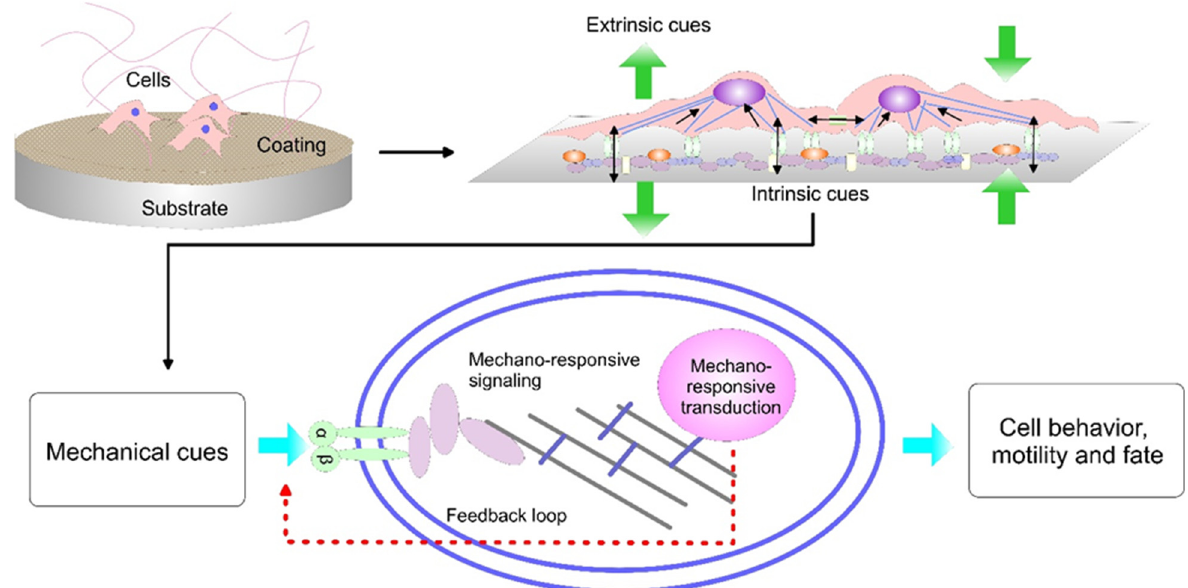
Figure 1. A schematic view of the influence of external mechanical forces and local (intrinsic) mechanical cues of the surrounding extracellular matrix on cell behavior of osteoblasts cultured on coated implants. The mechanical cues are transferred from the cell surface to the nucleus by the mechanisms of mechano-responsive signaling including the cytoskeleton. The mechano-responsive transduction activates downstream cell signaling cascades that determine the cell behavior, motility and fate. By a transcriptional feedback loop, the cells can change their mechano-environment by cytoskeletal remodeling and cell migration.